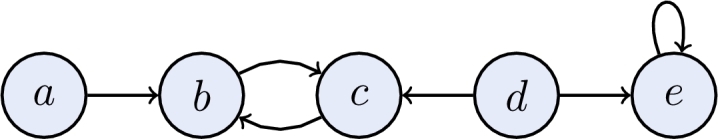
Example argumentation framework.